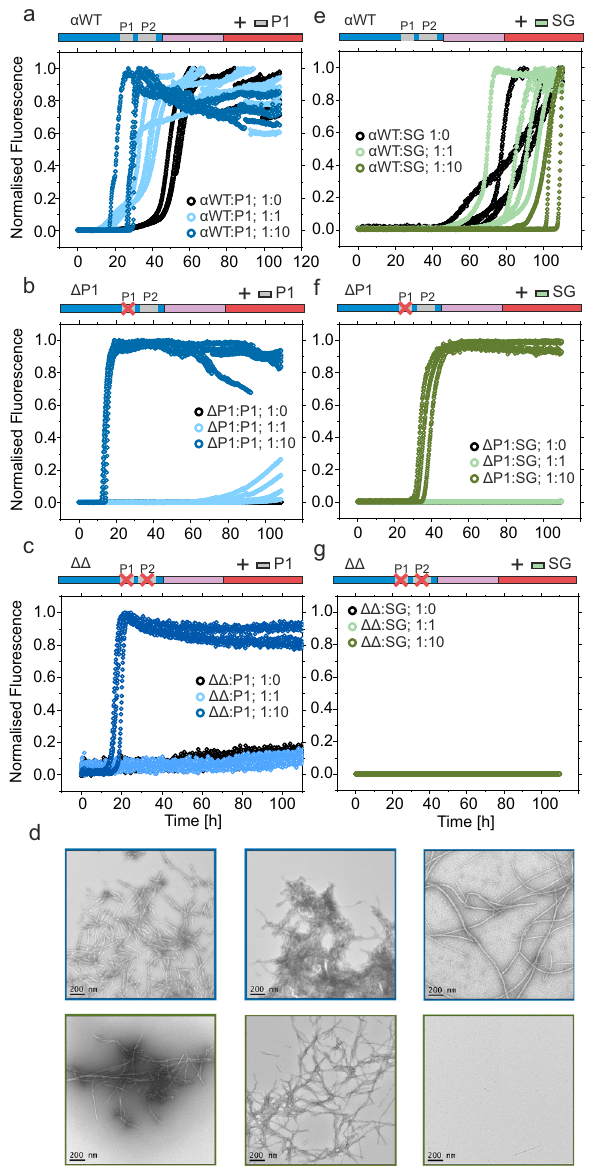
Fig. 3 | Amyloid formation kinetics of WT α Syn, Δ P1 and ΔΔ in the presence of thepeptidesP1orP1-SG. Amyloidformationkineticsof a , e WT α Syn, b , f Δ P1and c , g ΔΔ in the presence of different concentrations of P1-peptide ( a – c ) or peptide P1-GS ( e – g ). All experiments were carried out using 100 μ M α Syn and peptide concentrations of0 μ M,100 μ M or1mM,atpH7.5,200mM NaCl, 37°C,600rpm. Note that under conditions of no or low amyloid formation, data points for dif- ferent conditions overlay. Representative negative stain TEM images of samples with10-foldmolarexcessofpeptidetakenattheendpoint(110h)ofonebiological replicate ( n =2) are shown ( d ). Top, with peptide P1; lower, with peptide P1-SG. % pellet and t 50 values are shown in Supplementary Table 1b. Source data are pro- vided as a Source Data fi